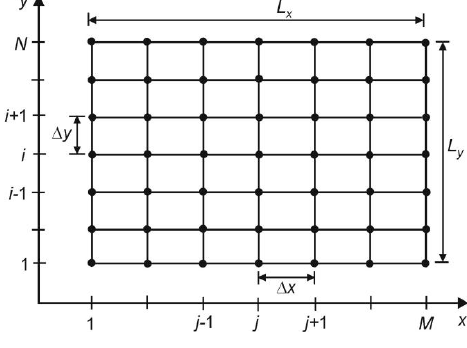
Figure 1. Spatial computational grid.